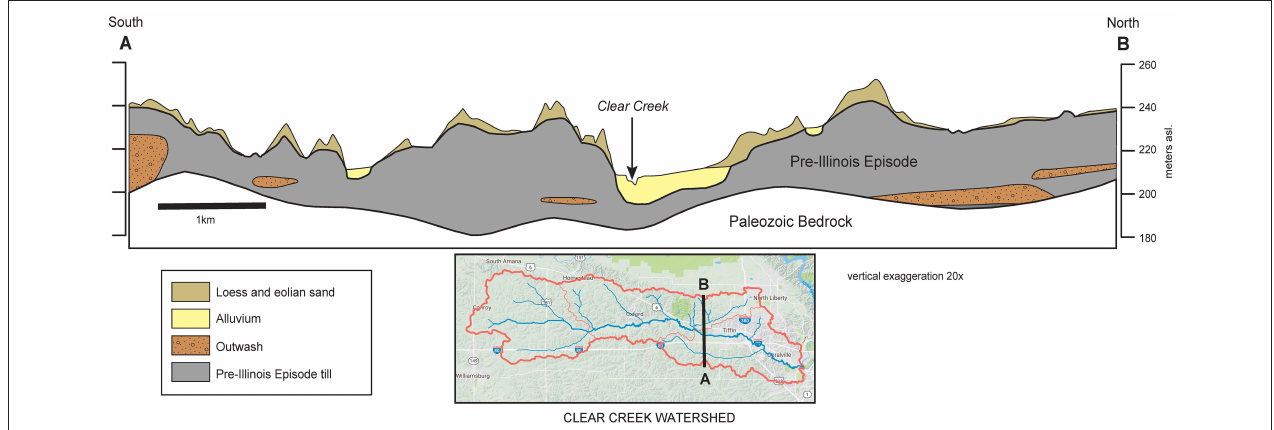
FIGURE 3 | Cross-section of the eastern portion of the Clear Creek Watershed, Iowa. (A,B) Inset map shows the location of the cross-section within the Clear Creek Watershed, outlined in red. Pre-Illinois Episode tills of the Alburnett and Wolf Creek formations occupy broad bedrock valleys cut into Devonian bedrock. Sand and gravel bodies, interpreted as glacial outwash, are present within and between these till units. At the surface, thick deposits of loess dating to the late Wisconsin—earliest Holocene are present along with alluvium deposited in modern river valleys.